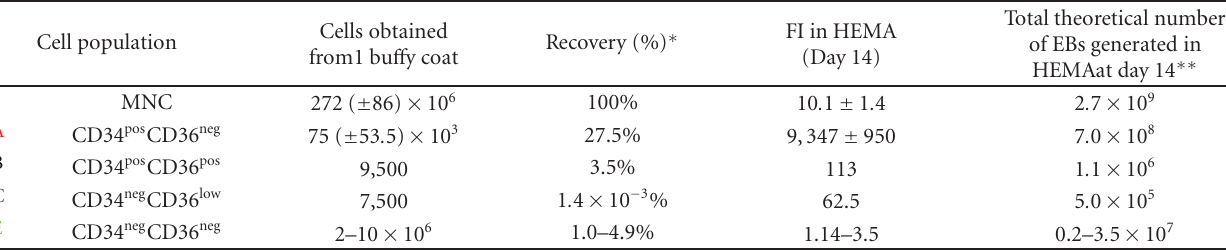
Recovery was calculated by dividing the total number of cells obtained after the purification per the theoretical number of cells present in MNC. The theo- retical cell number of each fraction was calculated by multiplying the frequency of the population, presented in Figure 1(a), per the average number of MNC obtained from an AB bu ff y coat (272 × 10 6 ). ∗∗ The theoretical total number of EBs obtainable at day 14 from each fraction was calculated by multiplyingthe total cell number of the fraction per the cor- responding